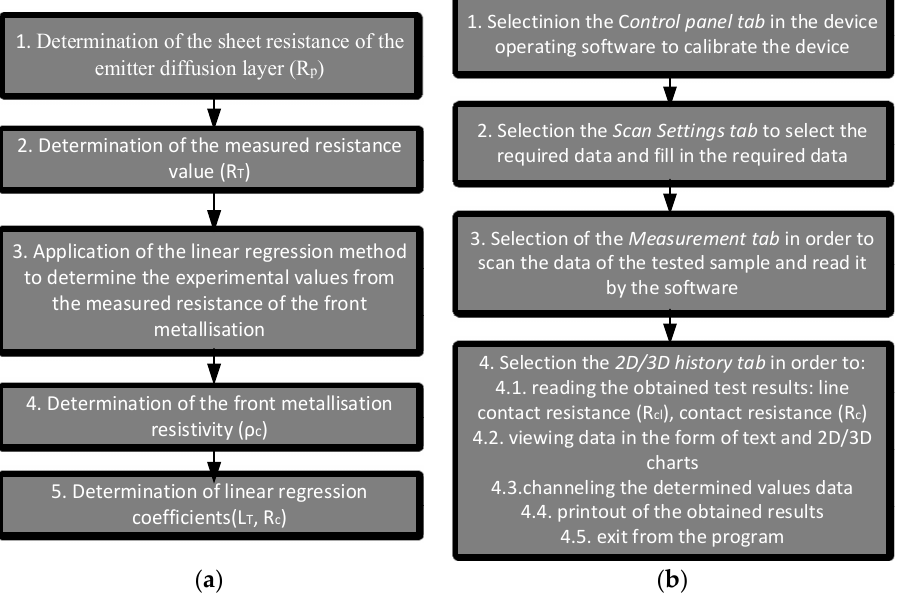
Figure 2. Sequence of actions when carrying out measurements using the ( a ) TLM and ( b ) PD methods.